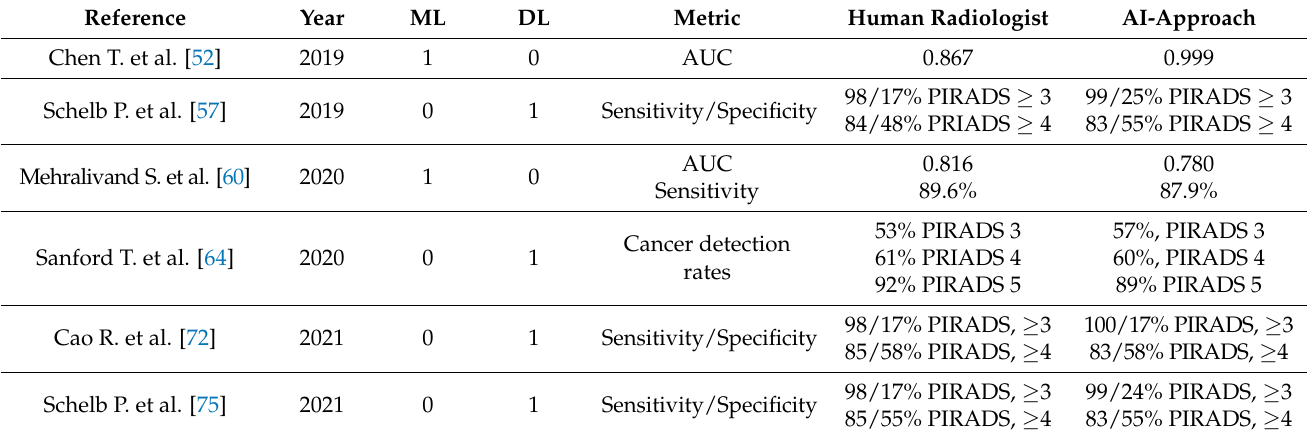
Table 2. Display of study results comparing human and AI-based